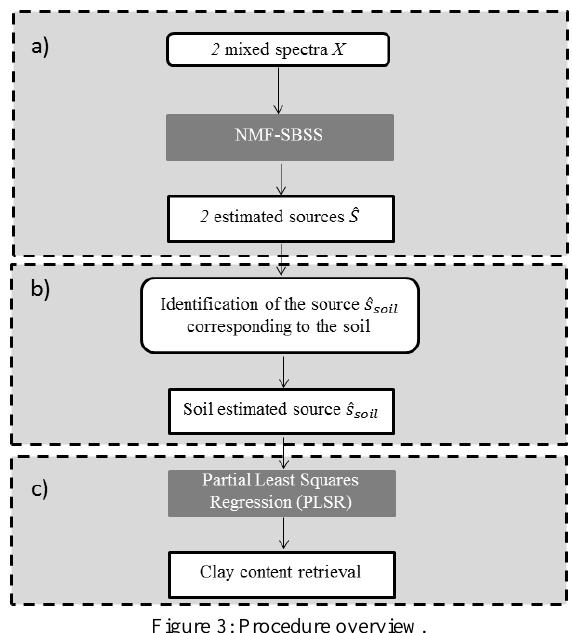
Figure 3: Procedure